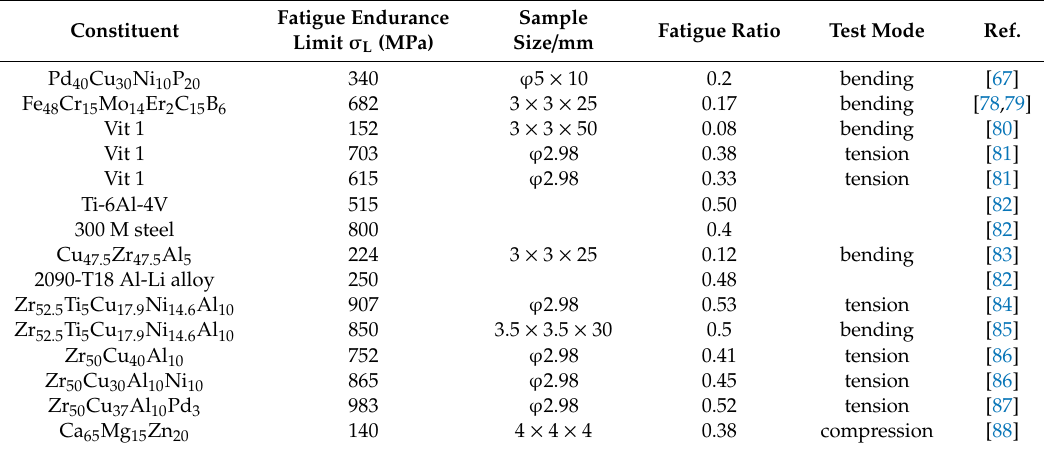
Table 2. Fatigue properties of some MGs and some commonly used metal